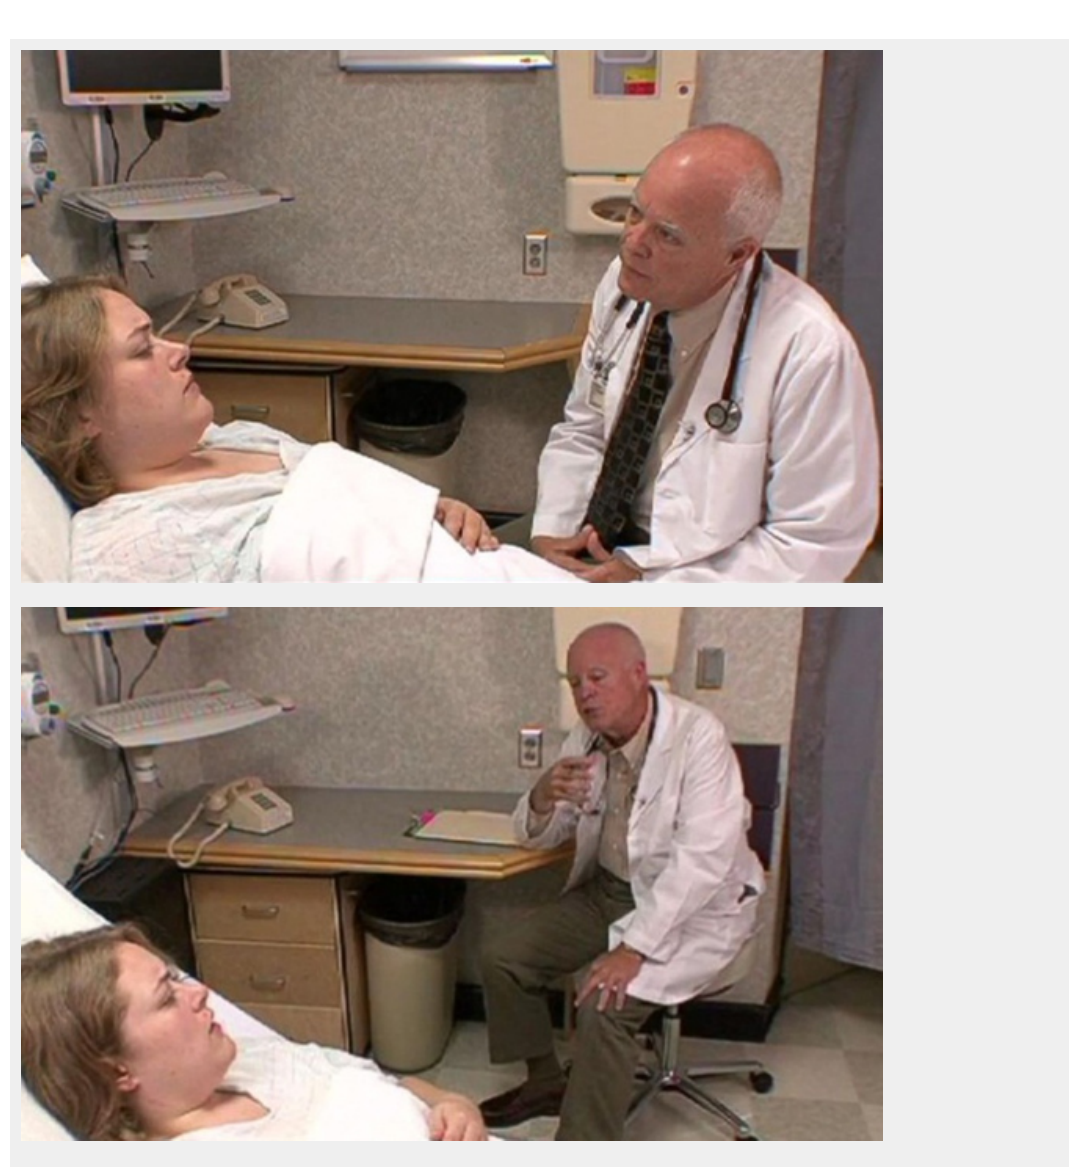
Figure 1 Screenshots of the error disclosure video vignettes. (1.) Competent error disclosure; (2.) incompetent error